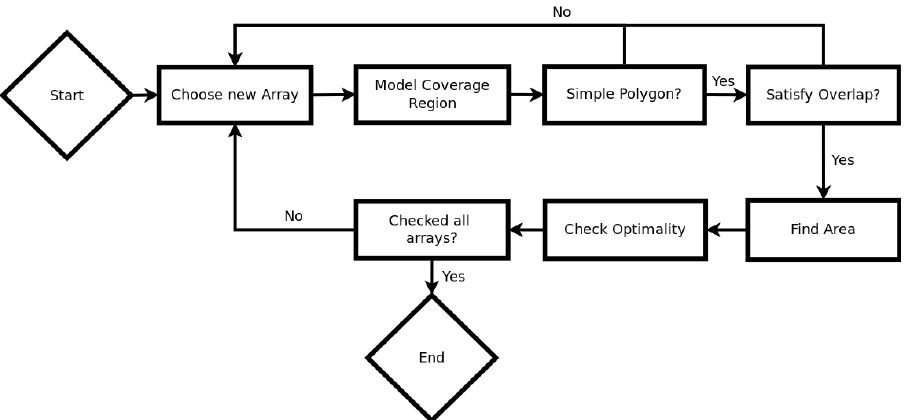
Figure 3. The general flow of our optimization algorithm. For each possible array, we model the coverage region, check to see that the result is a simple polygon which satisfies the overlap constraints, then find the area and compare that to the previously maximum area